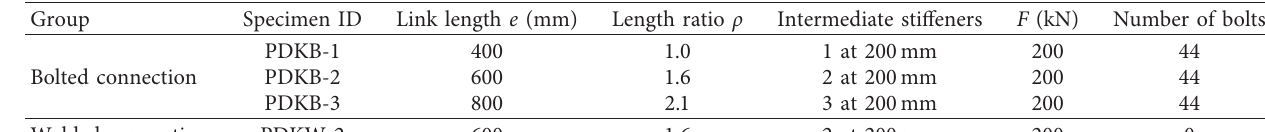
Figure 1: EBFs configuration used in this paper. Table 2: Specimens information.